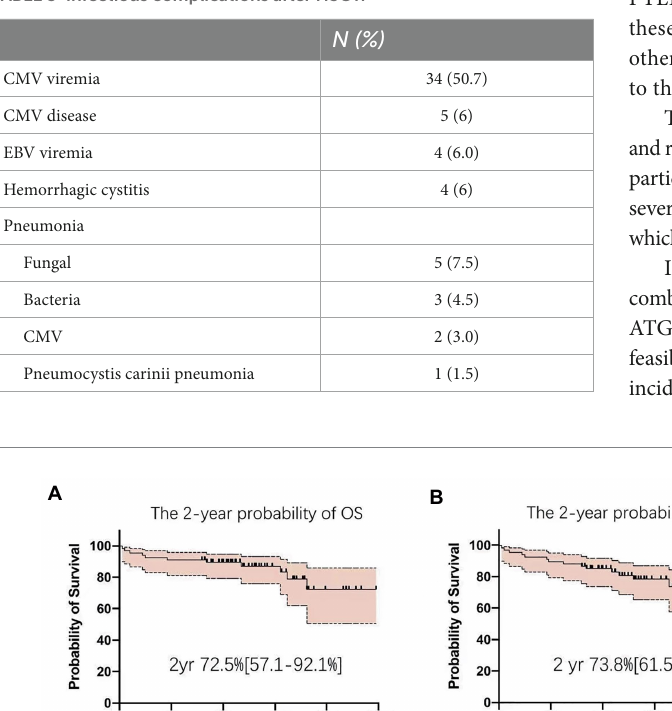
TABLE 3 Infectious complications after